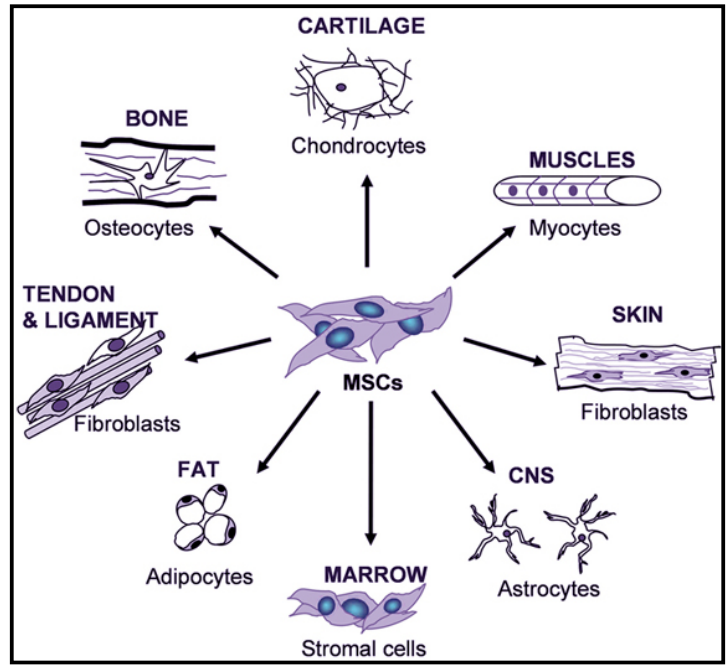
Figure 4. Multi-lineage potential of MSCs showing the potential to differentiate into various lineages making them the ideal candidates for cell-based tissue engineering strategies [34]. Copyright © 2018 by Frontiers in Bioscience. Reprinted by permission of Frontiers in Bioscience.